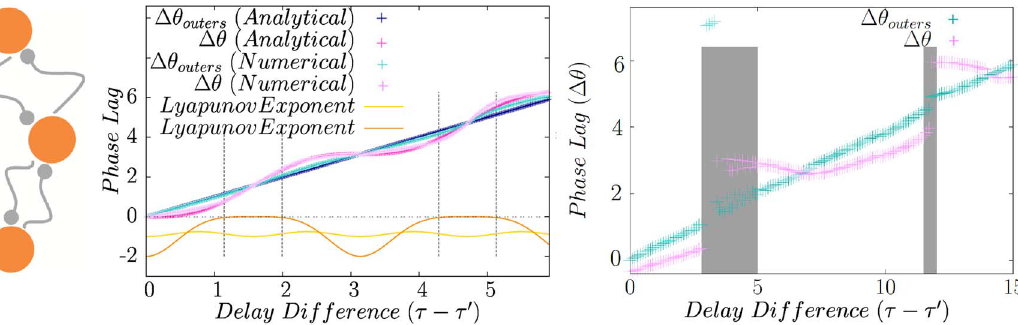
Fig. 11. Asymmetric variation of delays. The time lag of firing of the neurons is shown as a function of difference in delay times. Numerical results confirm outcome of analytic calculations for the phase lag. Lyapunov exponents are also shown. They must be both negative for a stable phase-locked mode. In the right figure similar results are shown for HH